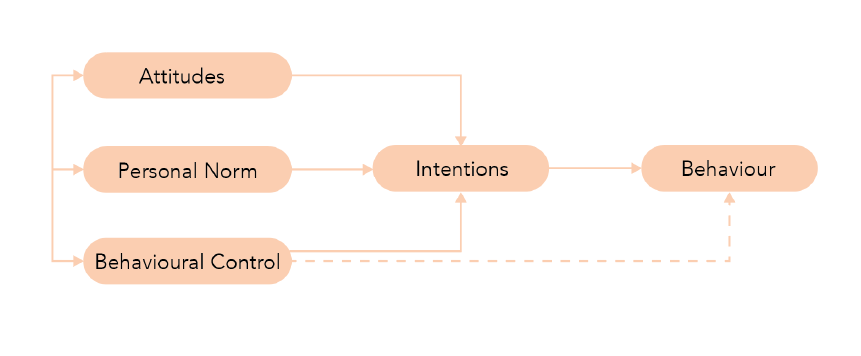
Figure 3. The Theory of Planned